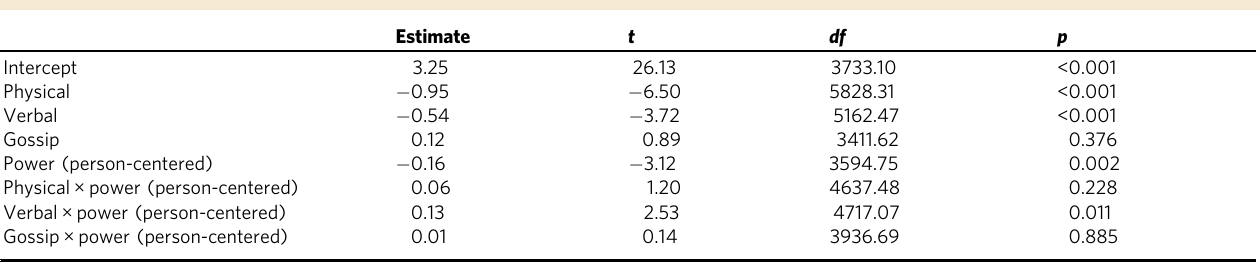
Table 3 Relative power and endorsement of punishment